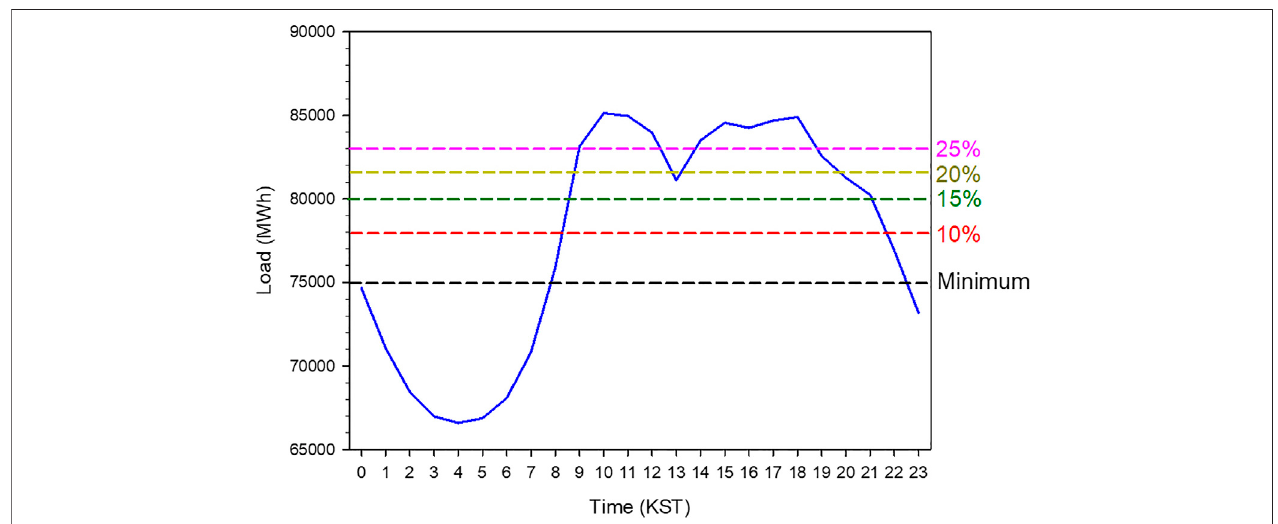
FIGURE 4 | A time series of electricity load averaged over 2 years from 2017 to 2018 as a function of hour. The dashed line indicates the level for peak load shave.